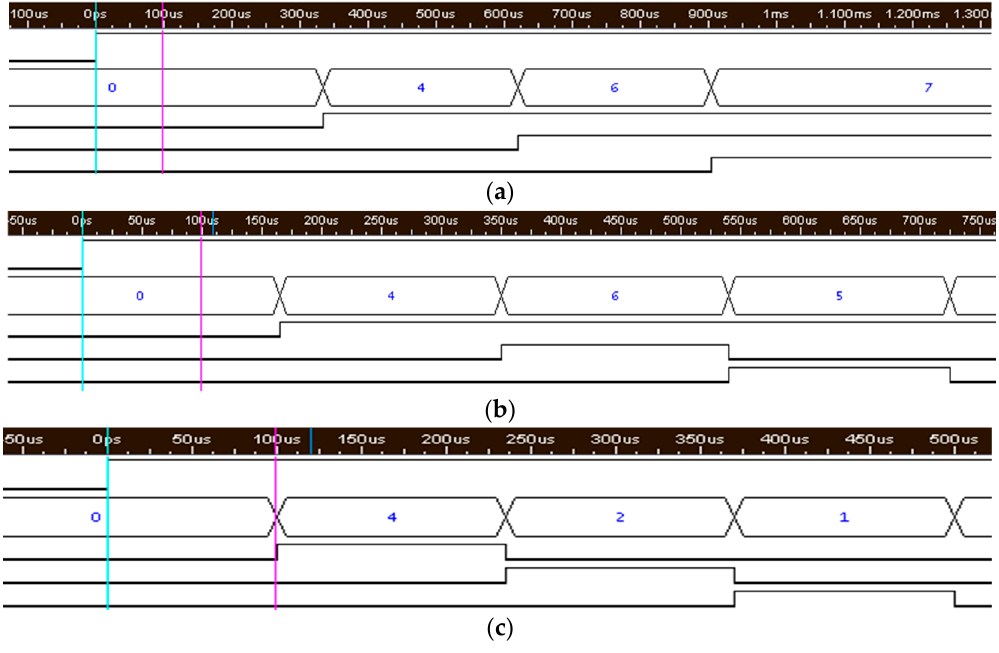
Figure 17. The measurement results of ATL: ( a ) Input clock of 24.8 kHz; ATL digital outputs = 111; ( b ) Input clock of 42.8 kHz; ATL digital outputs = 100; ( c ) Input clock of 60.0 kHz; ATL digital outputs = 000.